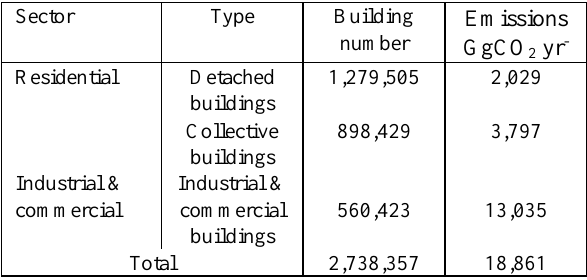
Table 2. Estimation result for Tokyo in 2014 by